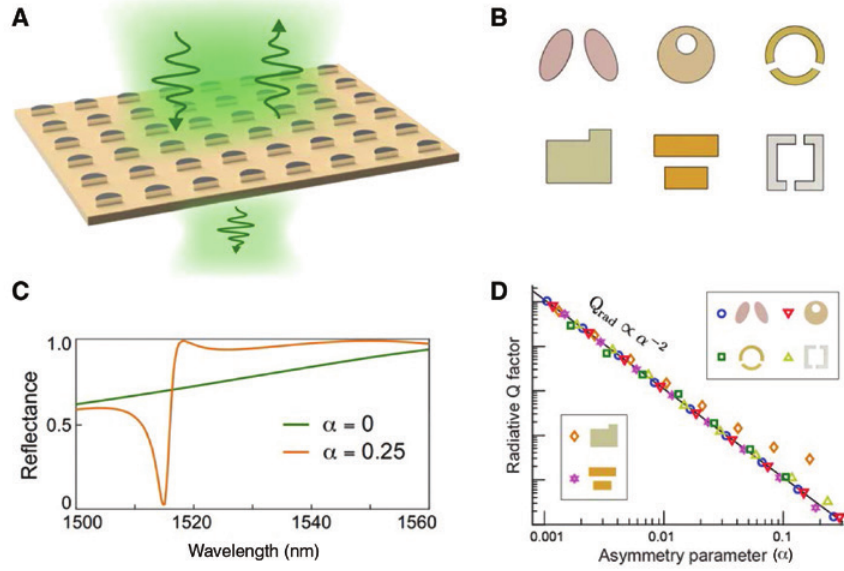
Figure 6: BICs in metasurfaces with a broken symmetry. (A) Schematic of the scattering of light by a metasurface. (B) Designs of the unit cells of asymmetric metasurfaces with a broken in-plane inversion symmetry of constituting meta-atoms supporting sharp resonances, as considered in Refs. [151–157]. (C) Example of evolution of the reflectance spectrum of the metasurface from the symmetric geometry ( α = 0) to a broken-symmetry geometry ( α = 0.25). Here, α is the asymmetry parameter. (D) Dependence of the Q factor on the asymmetry parameter α for all designs of symmetry-broken meta-atoms shown in (B) (log-log scale). Adapted with permission from Refs. [78,